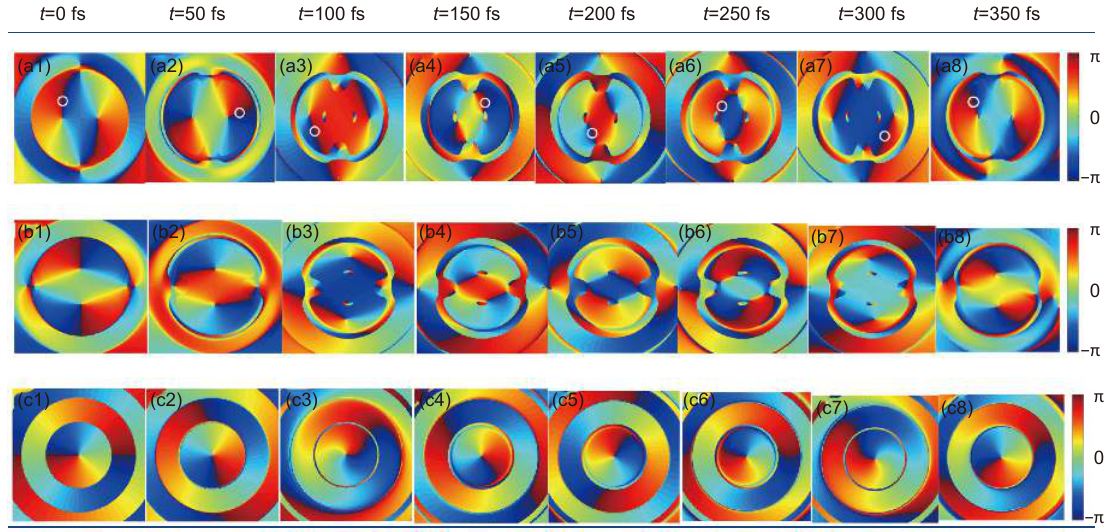
Fig. 4 | A phase gallery of tightly focused radially polarized light with the first-order vortex at different temporal intervals. The phase dis- tributions of the transverse | E x | 2 ( a1 – a8 ), | E y | 2 ( b1 – b8 ) and the longitudinal | E z | 2 ( c1 – c8 ) in the x−y plane with the time of t = 0 fs (a1–c1), 50 fs (a2–c2), 100 fs (a3–c3), 150 fs (a4–c4), 200 fs (a5–c5), 250 fs (a6–c6), 300 fs ( a7 – c7 ), and 350 fs (a8–c8), respectively. The white circles de- note the rotational phases. The color scale indicates the magnitude of the phase. The sizes for all of the images are 2 λ ×2 λ . Parameters are the same as those in Fig.